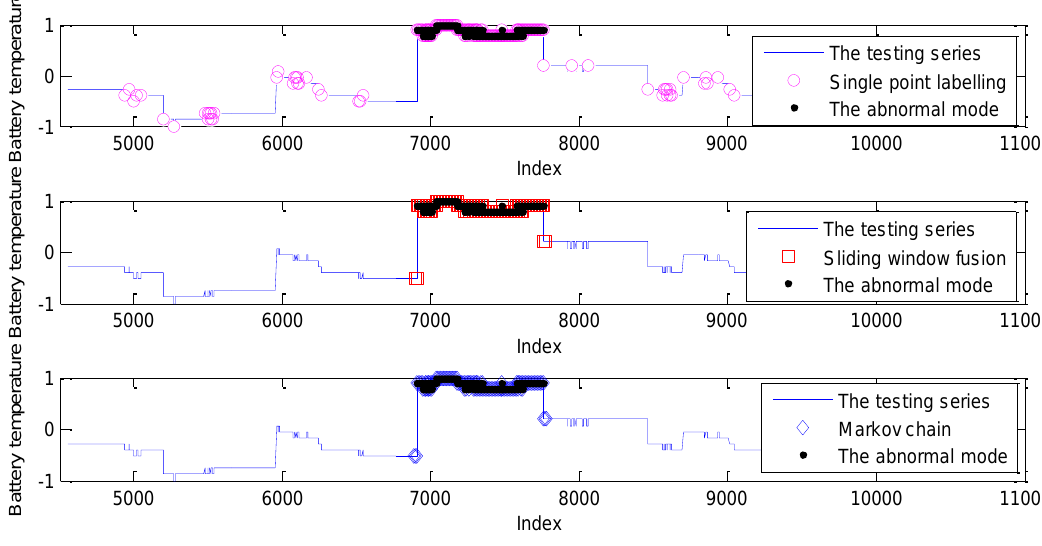
Figure 16. Anomaly detection with different labelling strategies. Table 5. The detection results based on the GPR model under different labelling strategies.